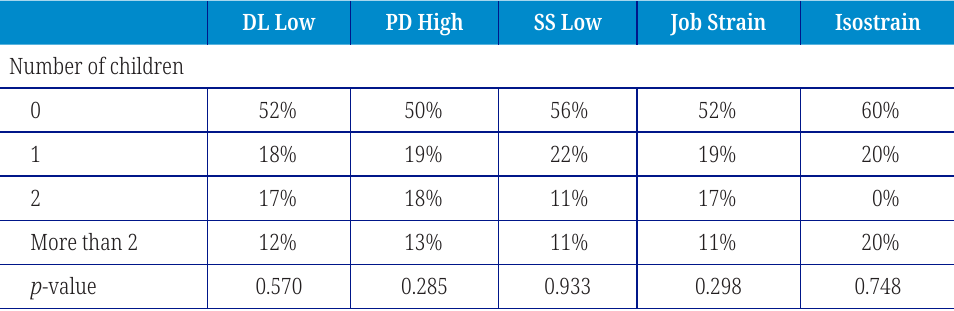
Table 5. Distribution of studied population according to number of children, familial situation and psycho-organizational dimensions (N =